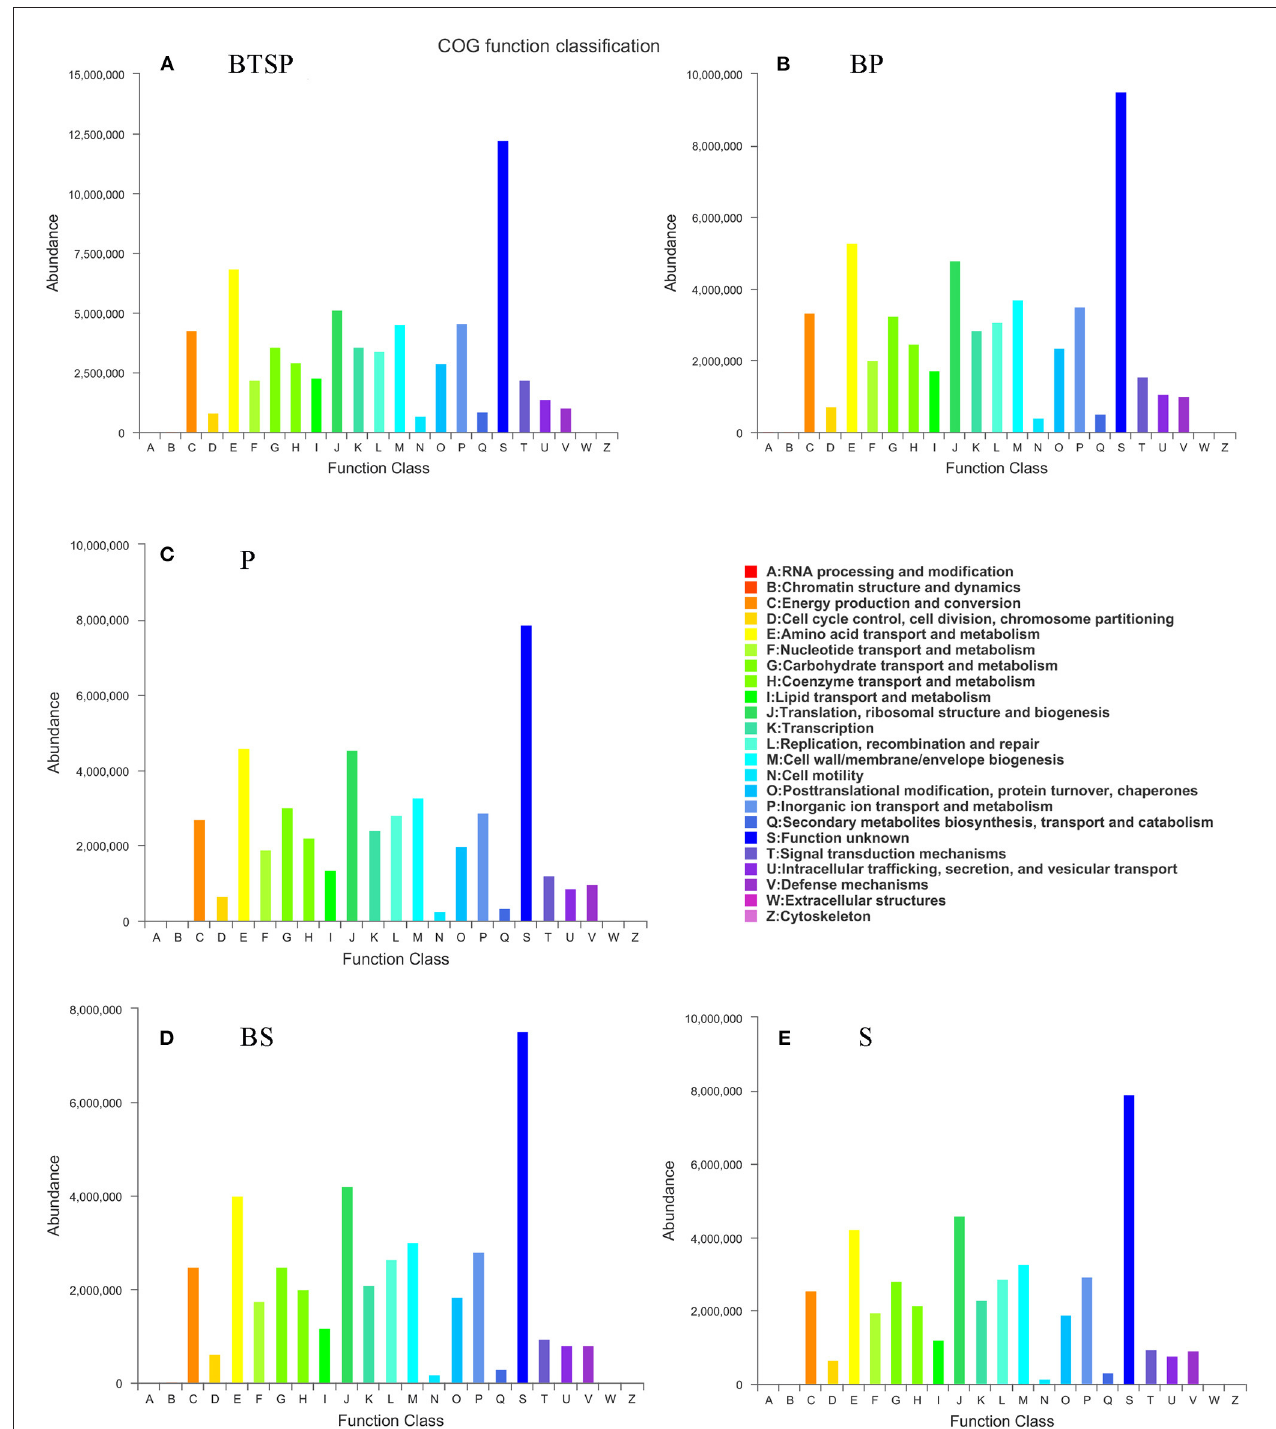
FIGURE 4 | Functional annotation of the microbiome based on Clusters of Orthologous groups of proteins (COG). (A–E) BTS plaque from BTS group (BTSP), supragingival plaque from BTS group (BP), supragingival plaque from control group (P), saliva from BTS group (BS) and saliva from control group (S), respectively.